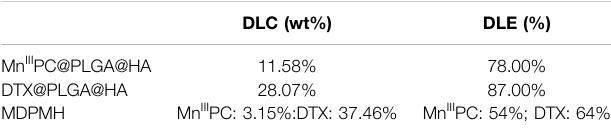
TABLE 1 | The drug loading content (DLC) and drug loading ef fi ciency (DLE) in different